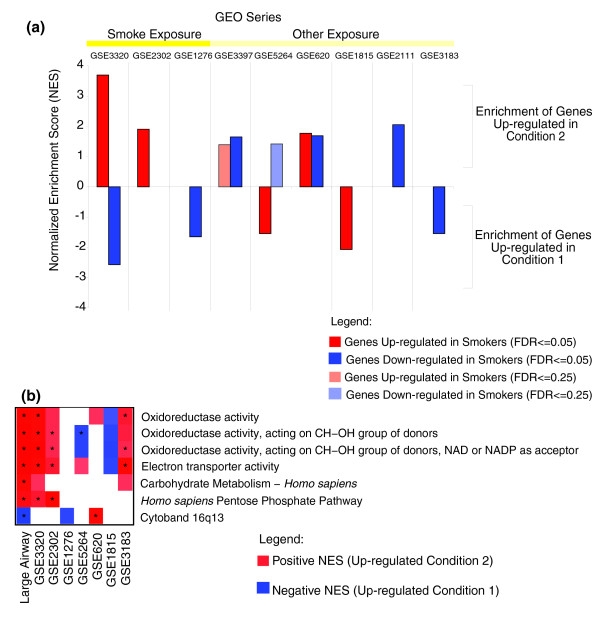
Similarities and differences between our dataset and other bronchial airway datasets. (a) GSEA was used to determine if there was a gene expression relationship between other airway datasets (see Table 3 for a description of conditions 1 and 2) and our dataset based on the genes we identified to be regulated by smoking. The normalized enrichment score is plotted for datasets that had a FDR < 0.25. (b) Gene lists derived from functional categories and chromosomal locations found to be over-represented by EASE analysis in our dataset were tested for enrichment in our dataset and the other ten datasets using GSEA. A false-color heatmap of the positive (red) and negative (blue) normalized enrichment scores (with a FDR < 0.25) is shown for each category. An asterisk indicates the results passed a stricter FDR < 0.05. The nine datasets and conditions that yielded significant results in either (a) or (b) are indicated in Table 3 by the presence of a single asterisk.